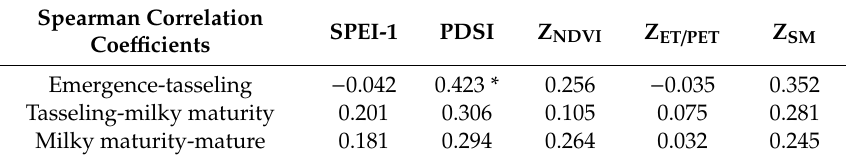
Table 5. Correlations between maize climatic yield anomalies and five